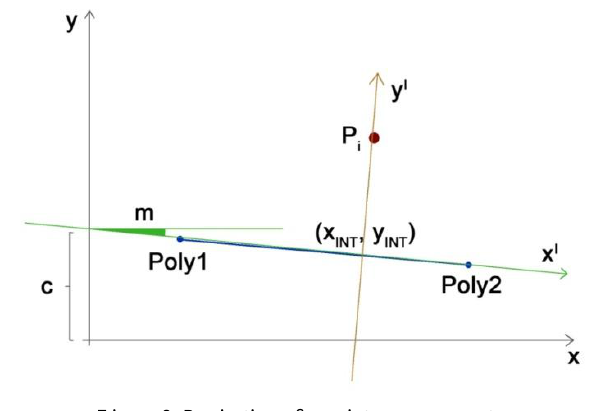
Figure 8. Projection of a point on a